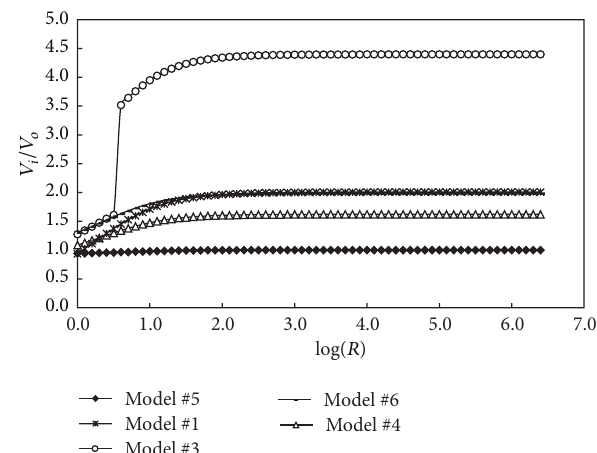
Figure 4: The ratios of the attractive potential energy for different model to that of model #7 for